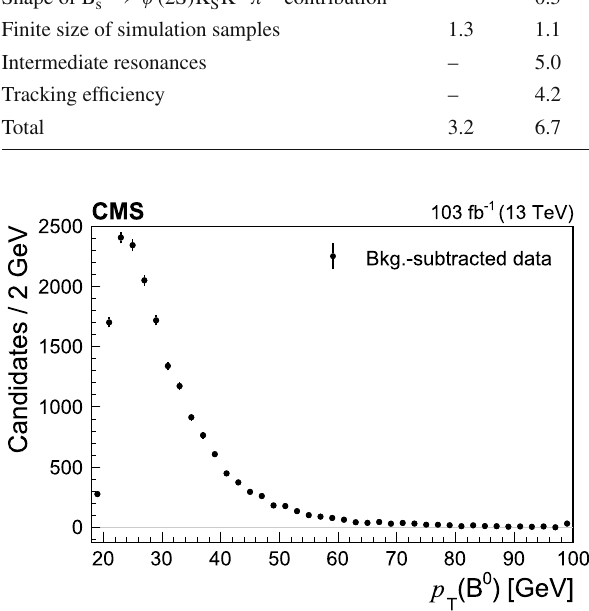
Fig. 4 Background-subtracted p T ( B 0 ) distribution in data for the B 0 → ψ ( 2S ) K 0 S signal. The last bin includes the overflow